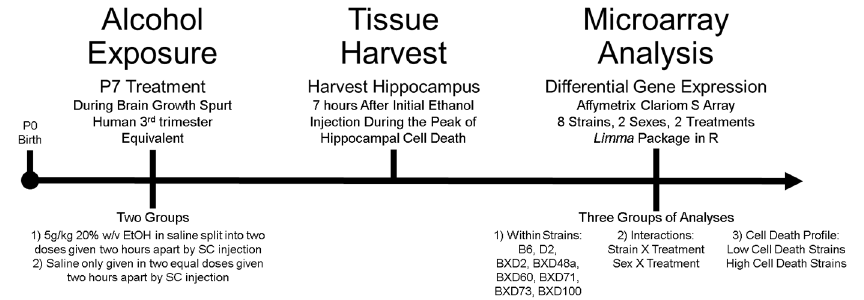
Figure 1. Overview of experimental design. Alcohol exposure paradigm ( left ), tissue harvest ( mid- dle ), and microarray analysis ( right ) are shown.